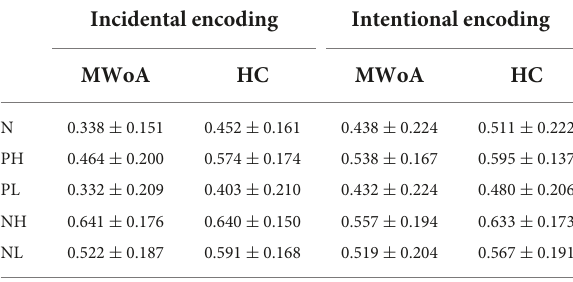
TABLE 2 The Pr value of patients with MWoA and healthy